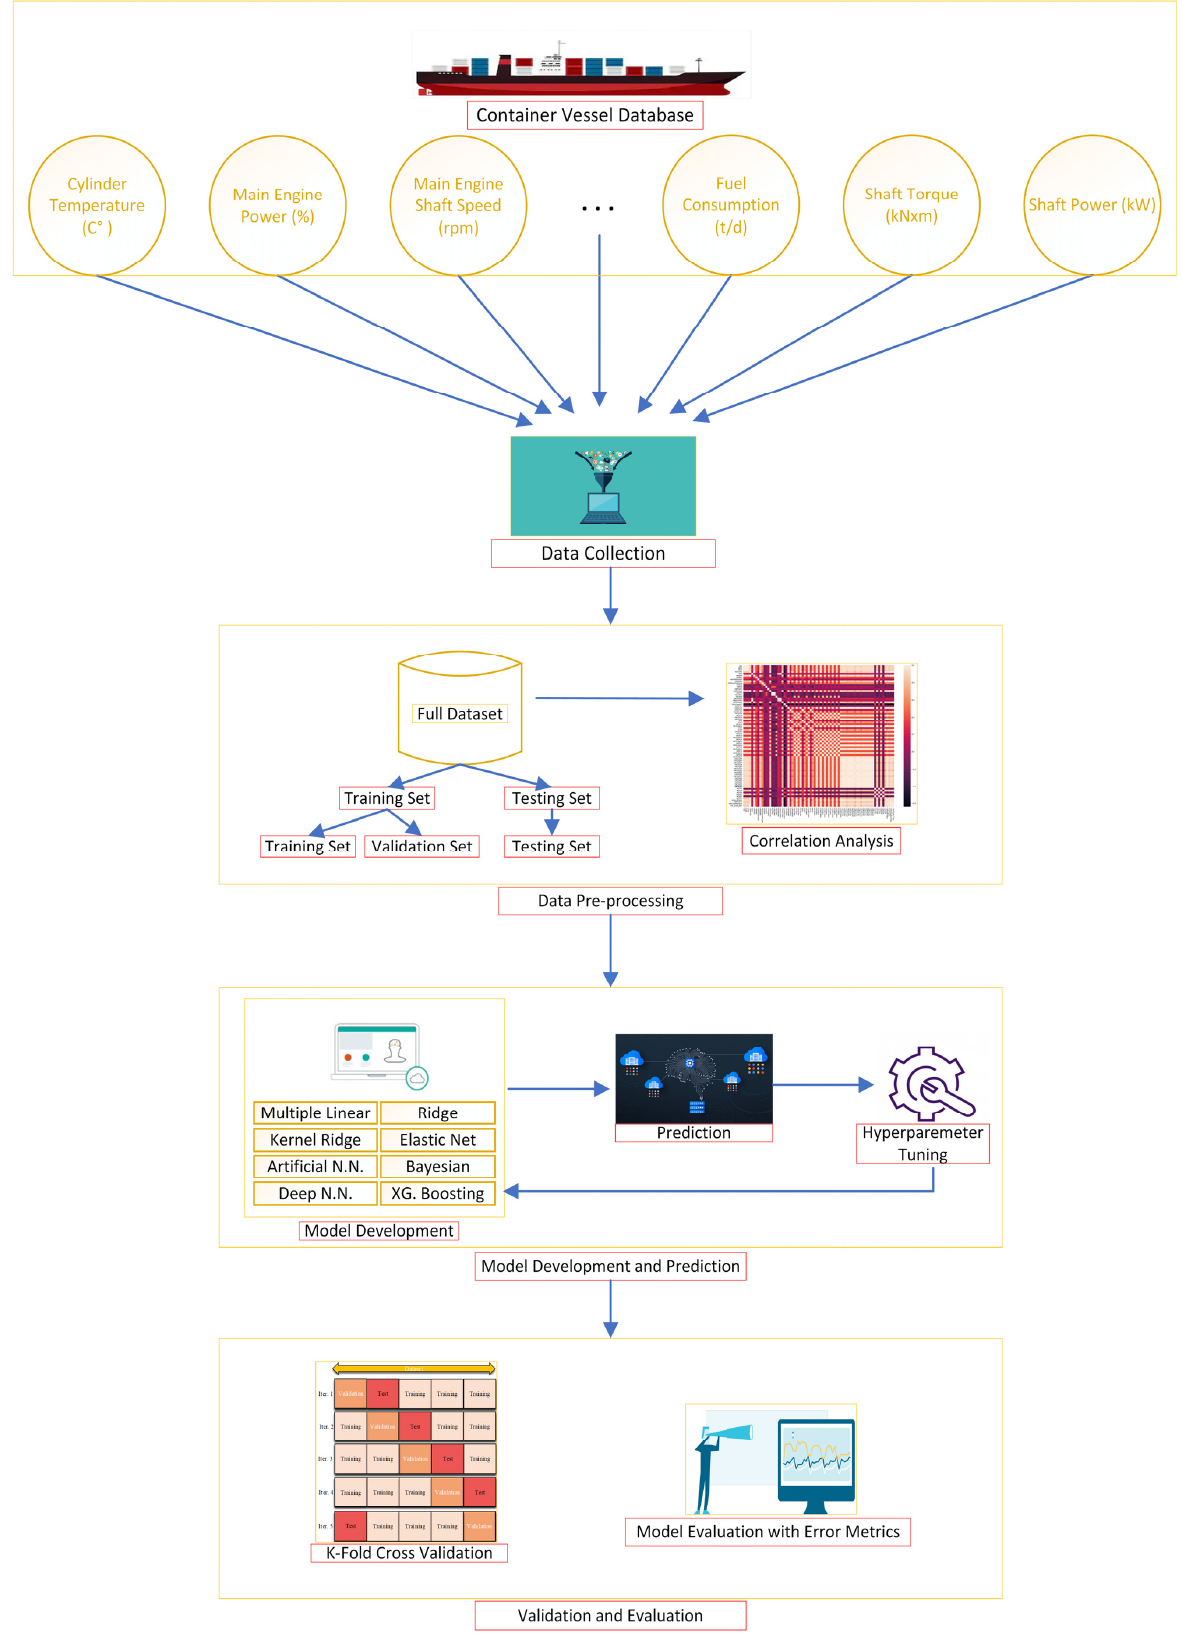
Figure 1. The methodology of the study.